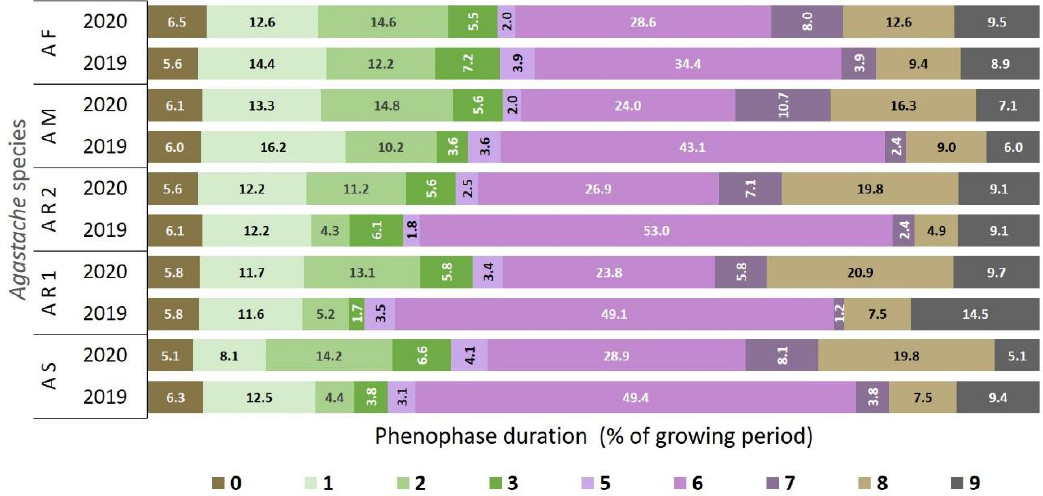
Figure 6. Comparison of the phenophase duration (%) from the growing period of Agastache : AF — A. foeniculum , AM — A. mexicana , AR2 — A. rugosa ‘After Eight’, AR1— A. rugosa , AS — A. scrophulariifolia . The duration of flowering (stage 6) ranged between species, both in the first and sec- ond year. In 2019, the shortest duration was recorded by A. foeniculum. Both A. rugosa as